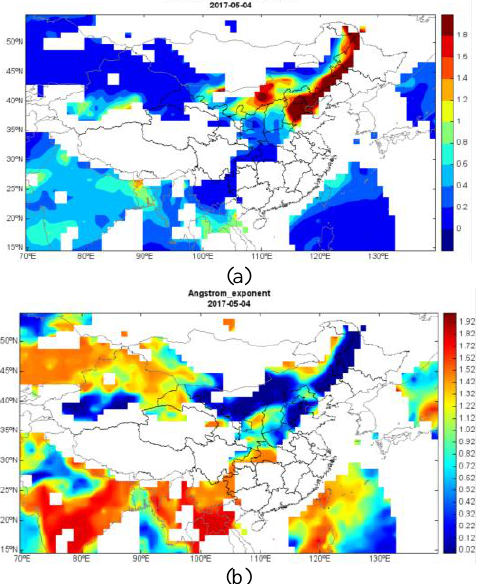
Figure 4. VIIRS-Suomi NPP Level-2 aerosol optical depth (a) and angstrom exponent (b) on 4 May 2017